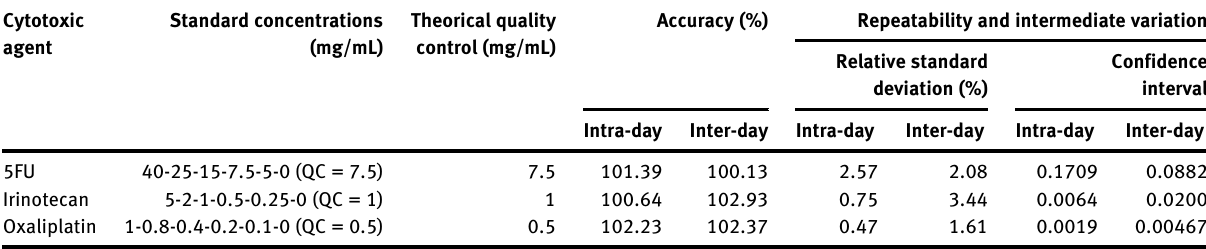
Table  : Accuracy and precision evaluation of the High Performance Liquid Chromatography method. Cytotoxic